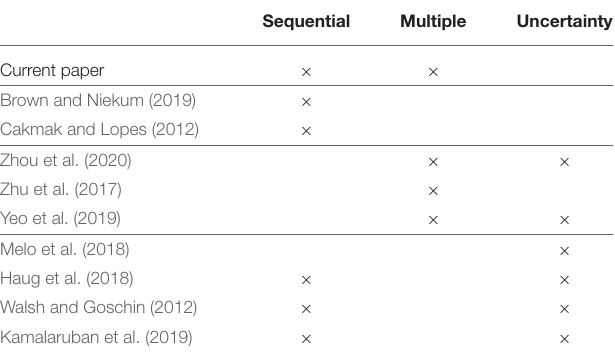
TABLE 1 | Comparative analysis of the most relevant works. Sequential Multiple